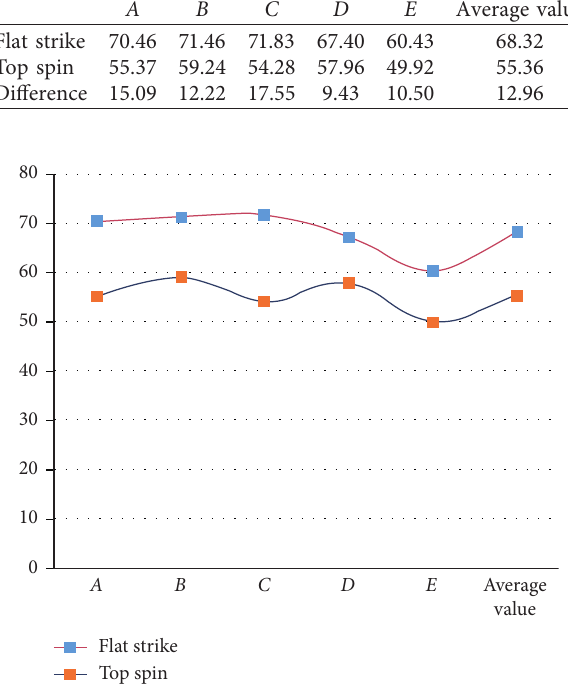
Figure 15: Statistical diagram of the angle between the racket and the ground at the moment of hitting the ball (unit: °